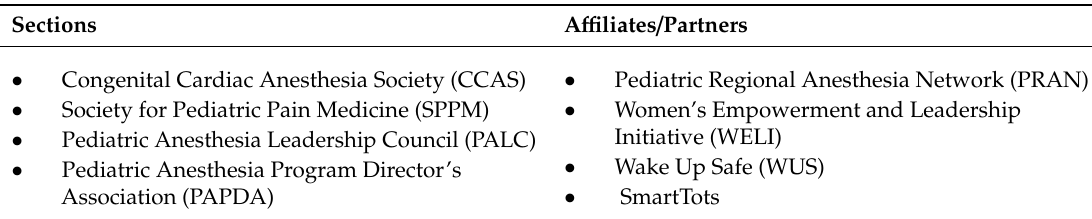
Table 3. SPA subsocieties, sections, partnerships / a ffi liates.